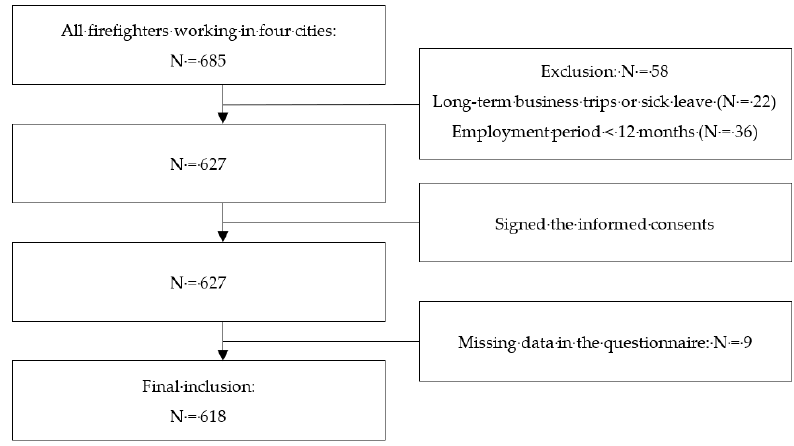
Figure 1. Flowchart of study participation.